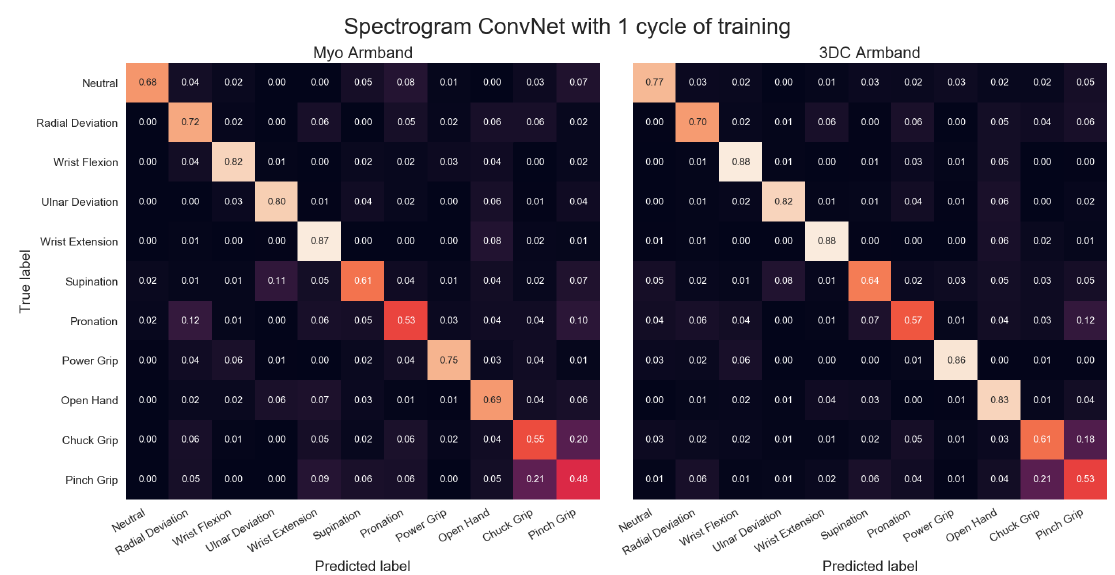
Figure A7. Confusion Matrices for the Myo and the 3DC Armband employing the Spectrogram ConvNet for classification and one cycle of training. Lighter is better.